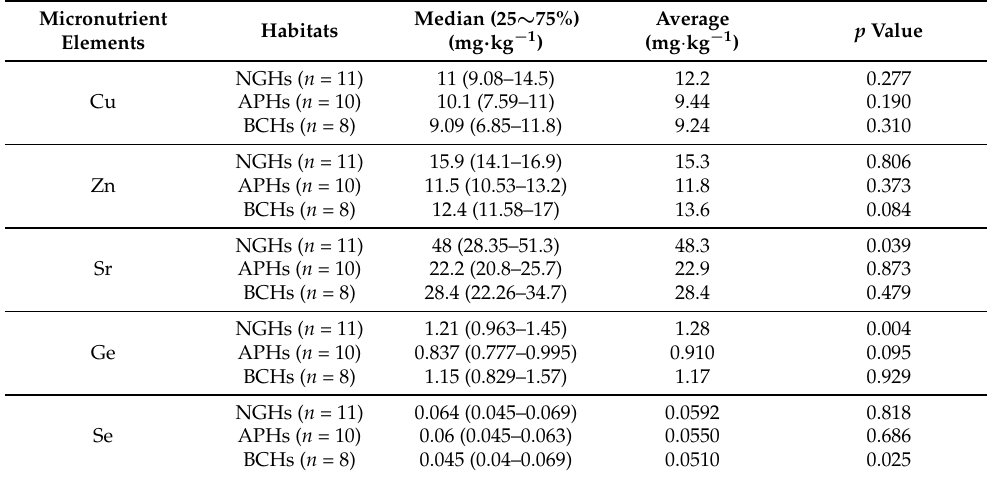
Table 5. Parameters on micronutrient elements distribution characteristics of roots in various habitats, Hebei